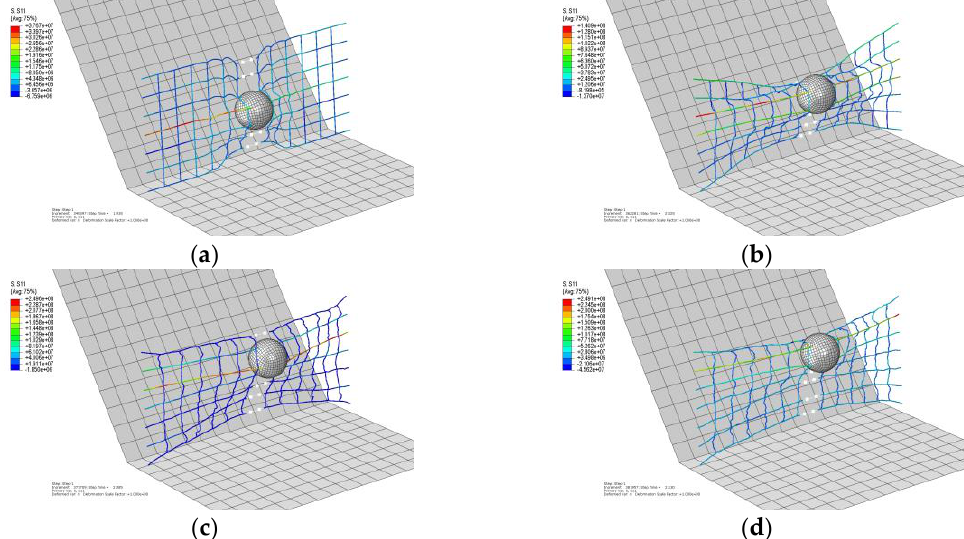
Figure 15. Stress distribution in the net protection system after impact, with using a brake frame, ( a ) 0.12 s after impact; ( b ) 0.21 s after impact; ( c ) 0.27 s after impact; and ( d ) 0.315 s after impact.